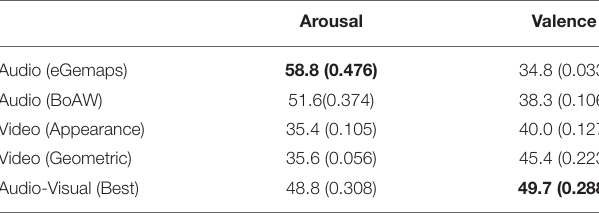
TABLE 2 | OMSVM evaluation with different modalities in terms of unweighted average recall UAR (%) and weighted kappa k w (reported inside parenthesis). Arousal